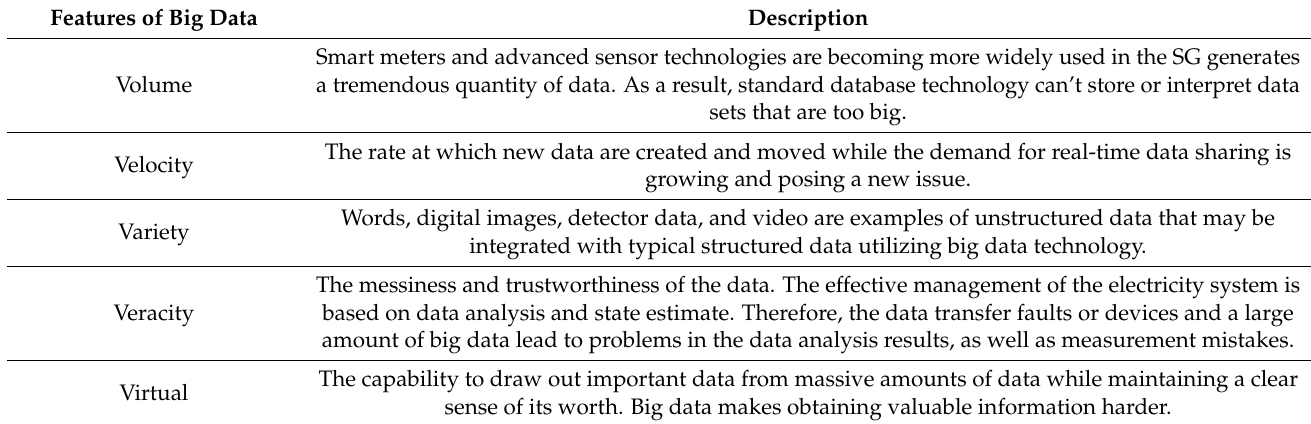
Table 4. Main features of big data in smart grids as